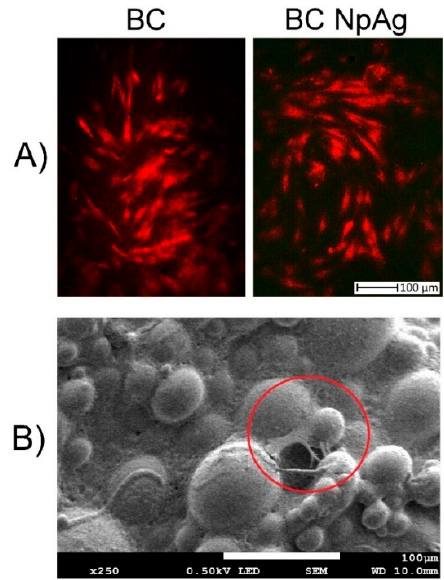
Figure 7. DPSC adhesion to the surface of bone cement (BC) and BC containing nanoAg (BC NpAg) (3% w / w) after 24 h (the presented pictures are representative for 3 experiments): ( A ) Images from a fluorescence microscope, Evans blue straining of cells frown on BC and BC-NpAg; ( B ) images from a scanning electron microscope for BC-NpAg showing adhered cells marked by red circle.